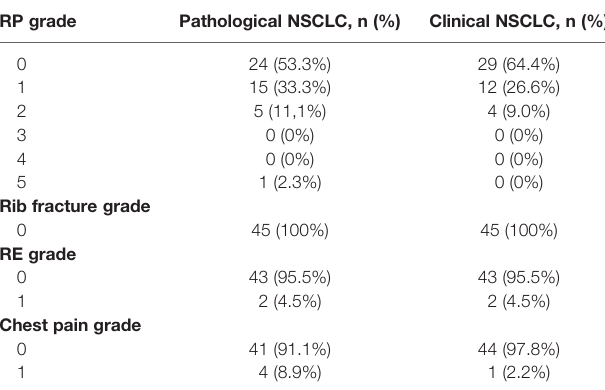
TABLE 3 | Summary and comparison of outcomes with long-term follow-up in patients with pathological NSCLC or clinical lung cancer after PSM analysis.